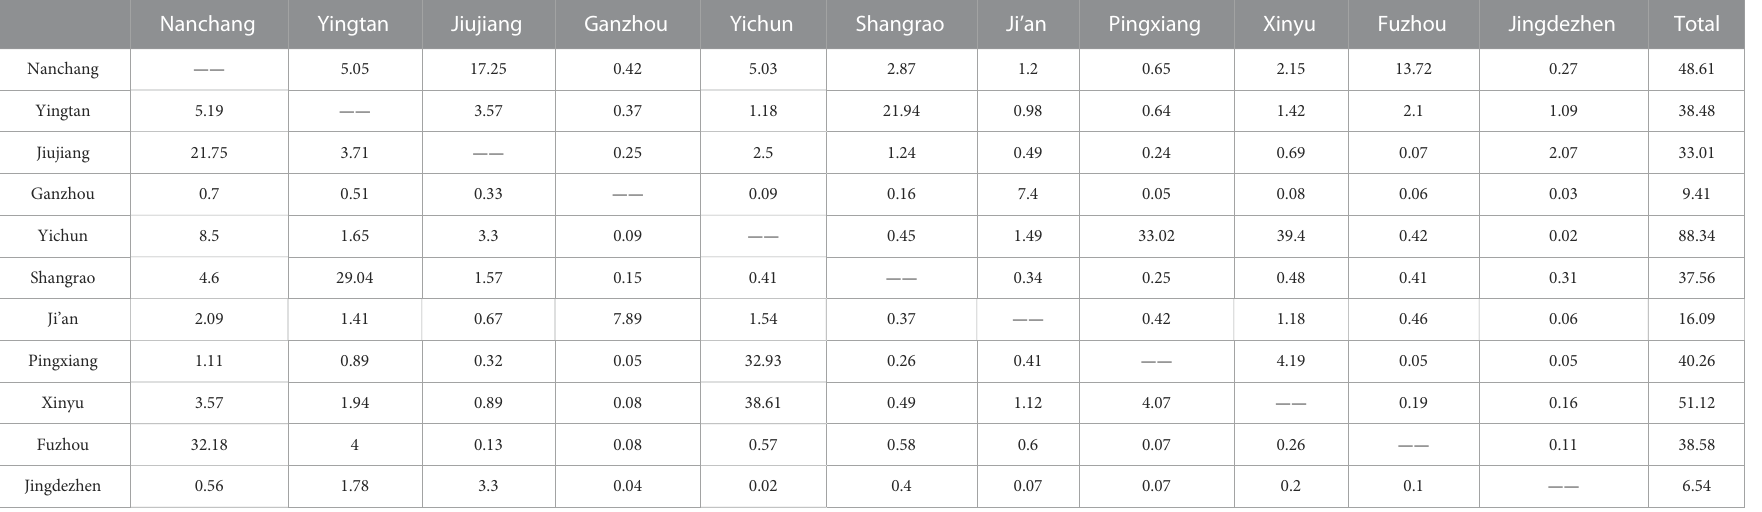
TABLE 8 Economic connections of 11 cities in Jiangxi Province before the opening of high-speed rail. Nanchang Yingtan Jiujiang Ganzhou Yichun Shangrao Ji ’ an Pingxiang Xinyu Fuzhou Jingdezhen Total Nanchang —— Yingtan